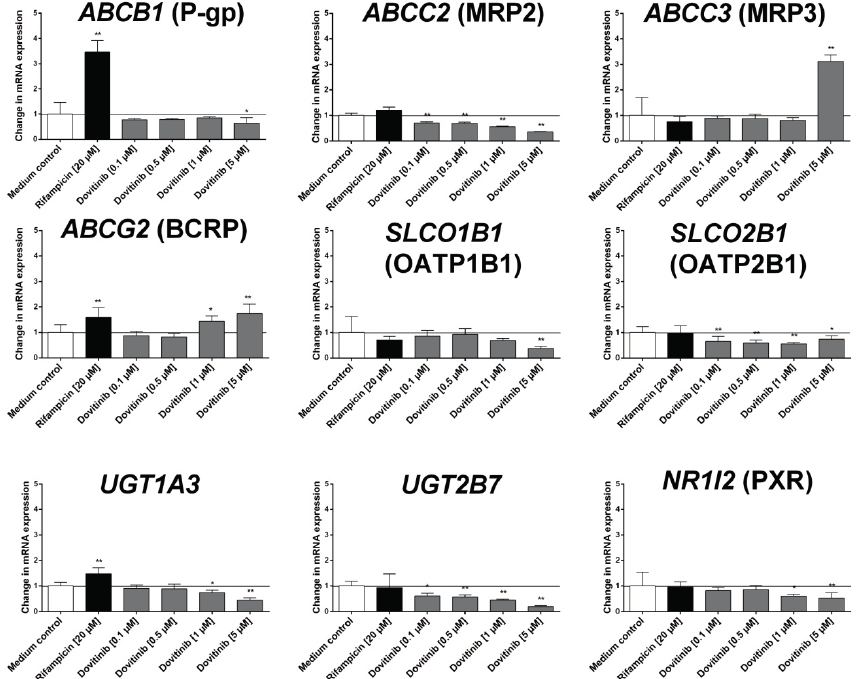
Figure 2. Induction assay. Concentration-dependent effect of dovitinib (0.1–5 µM) and 20 µM rifampicin (positive control) after four days on mRNA expression in LS180 cells compared to untreated medium control. Expression data were normalised to the housekeeping gene G6PDH . Data are expressed as mean ± SEM for n = 8 (four biological replicates and two PCR runs for every sample) and normalised to medium control (set to 1). The differences in mRNA expression following incubation with the compounds investigated compared with the respective vehicle control were tested using ANOVA with Dunnett’s post hoc test. * p < 0.05, ** p < 0.01.